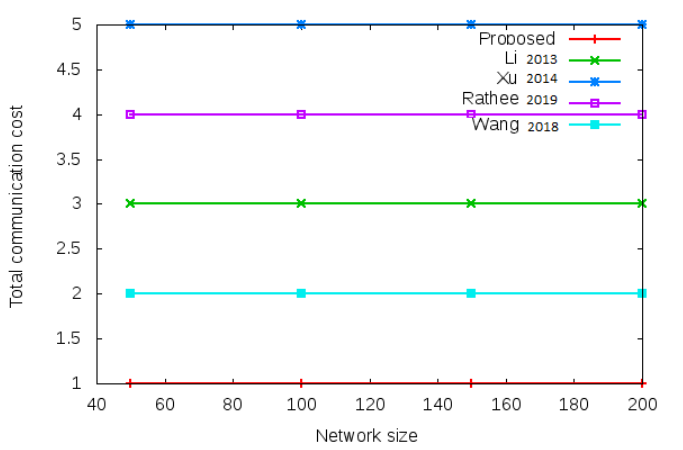
Figure 7. Total communication cost of proposed protocol versus existing protocols with different net- work size of 50, 100, 150, and 200 nodes during login process. Total communication cost comparison during login operation is given in column 1, row 6 of Table 3 (i.e., 4 vs. 6 vs. 9 vs. 5 vs. 7).